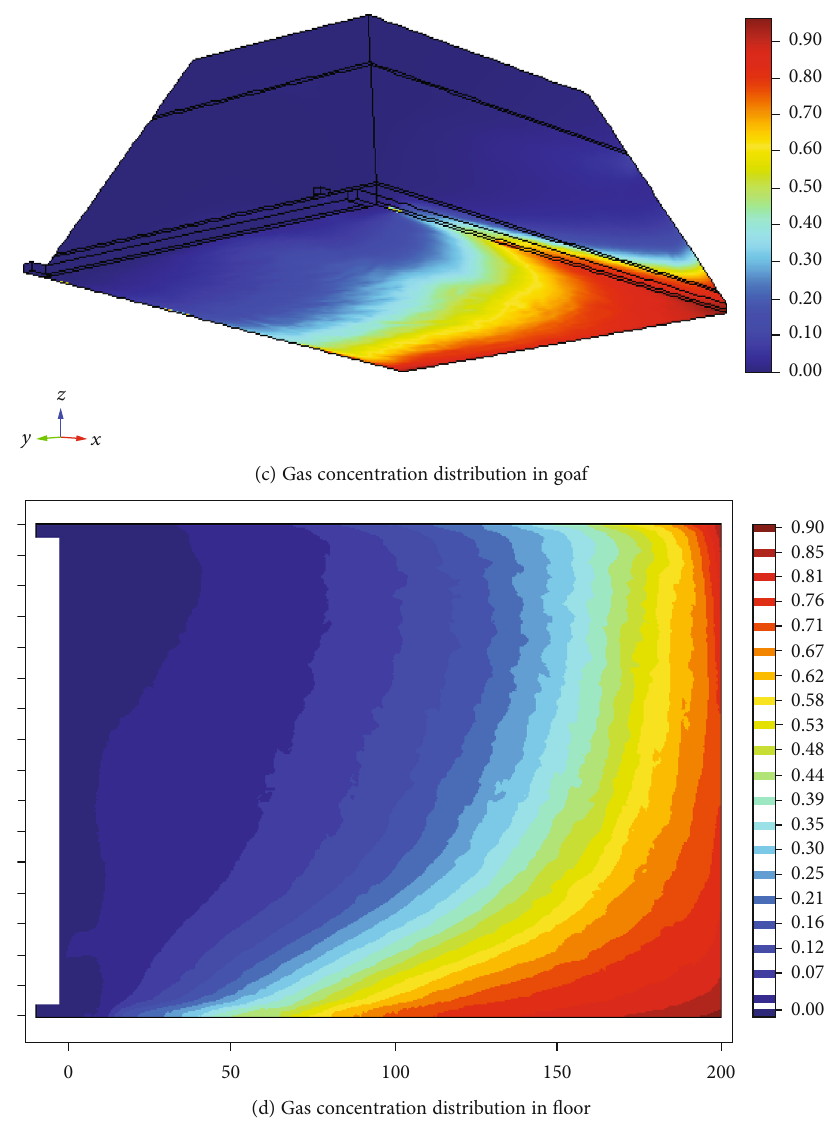
Figure 9: Distribution of fl ow fi eld and concentration fi eld at z = 1 : 5m in the goaf fl oor under the condition of high pumping